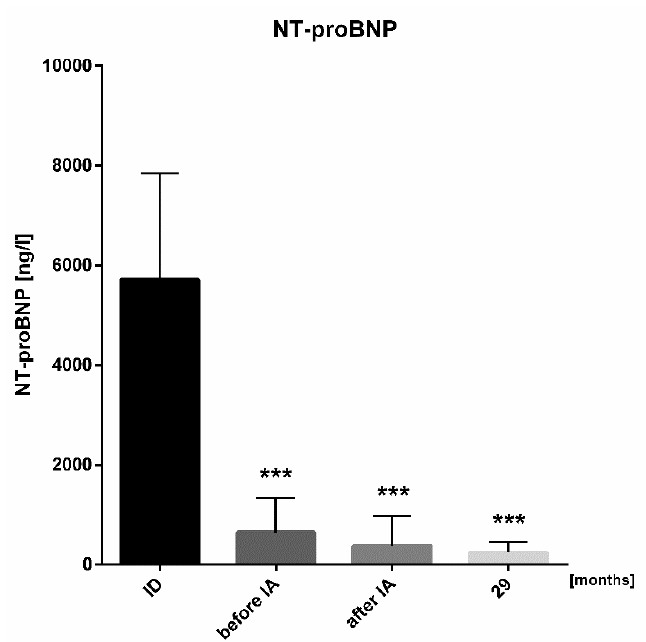
Figure 4. Dynamics of NT-proBNP. NT-proBNP was analyzed at initial diagnosis (ID), on admission for immunoadsorption (IA) on optimal heart failure treatment (before IA), before discharge from hospital (after IA) and at long-term follow-up (n = 24, *** p < 0.0001)).